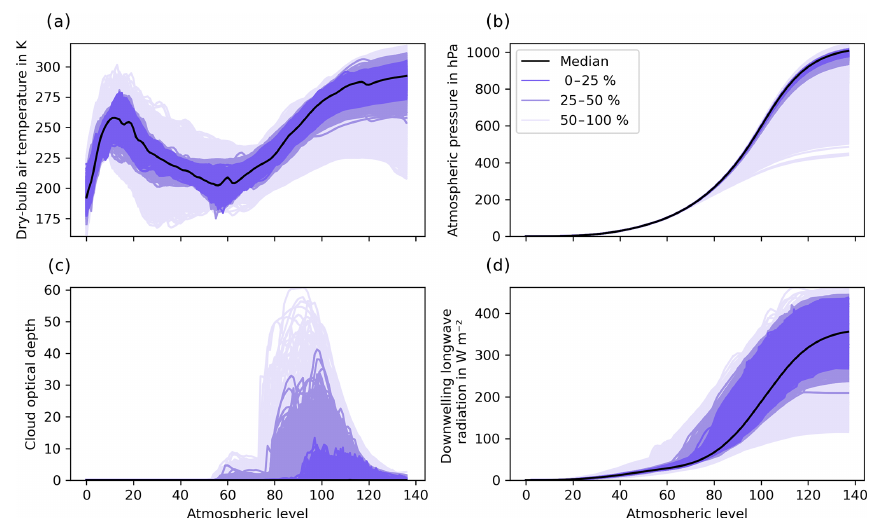
Figure 2. Profiles of (a) dry-bulb air temperature, (b) atmospheric pressure, and (c) cloud layer optical depth from the NWP-SAF dataset (25000 profiles; Eresmaa and McNally, 2014) as well as corresponding profiles of longwave radiation computed using the toy physical model described in Sect. 2.4. Profiles are ordered using band depth statistics (López-Pintado and Romo, 2009), shown for their most central (median) profile, and grouped for the central 0%–25%, 25%–50%, and